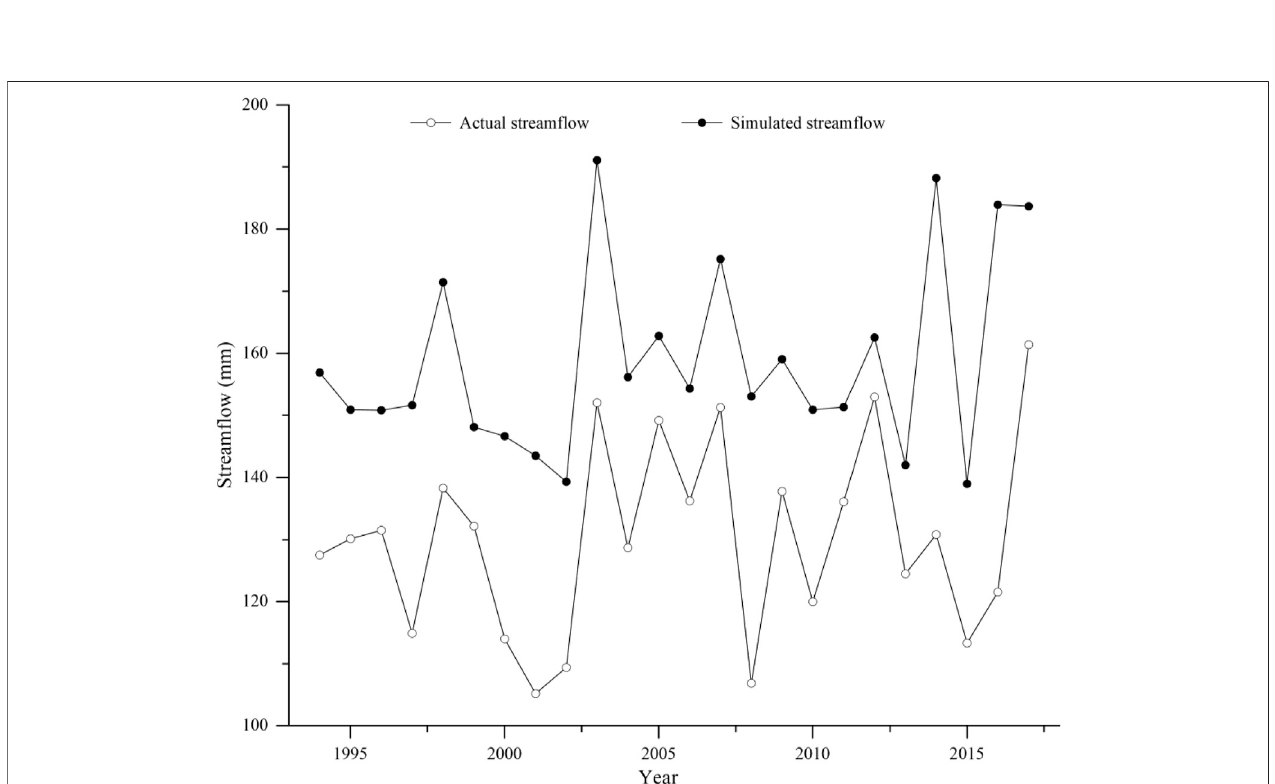
FIGURE 5 | Double cumulative curve comparison of simulated values and observed values in the changed period.